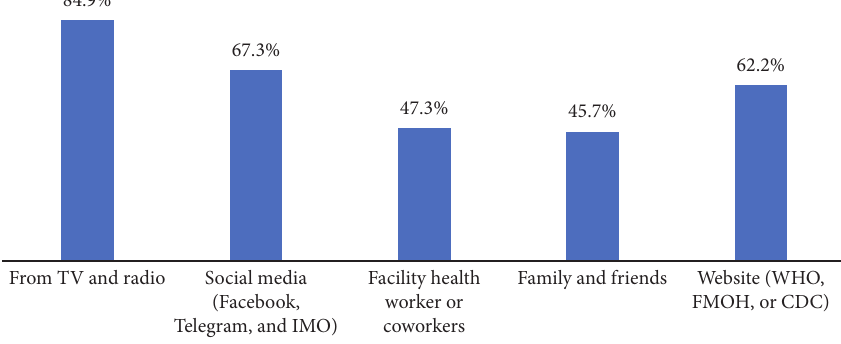
Figure 1: Source of information about COVID-19 Table 4: Bivariate and multivariate logistic regression analysis for factors associated with poor COVID-19 preventive practice among HCWs in Northwest Ethiopia, 2020.